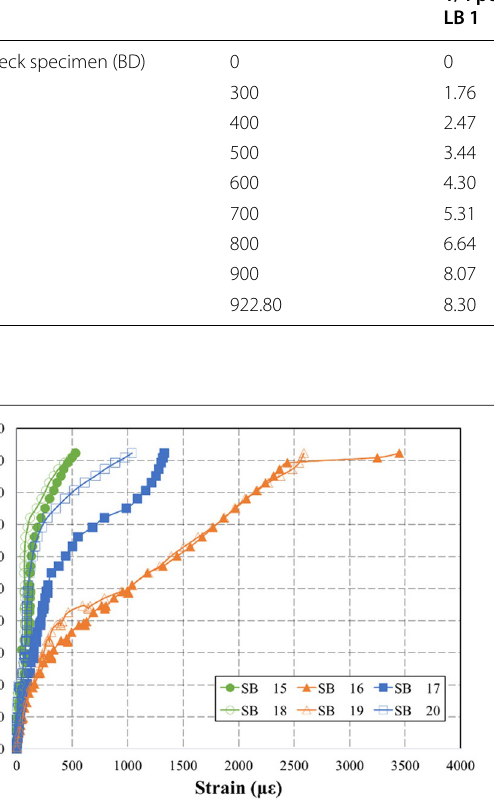
Fig. 13 BD load–steel strain curve.